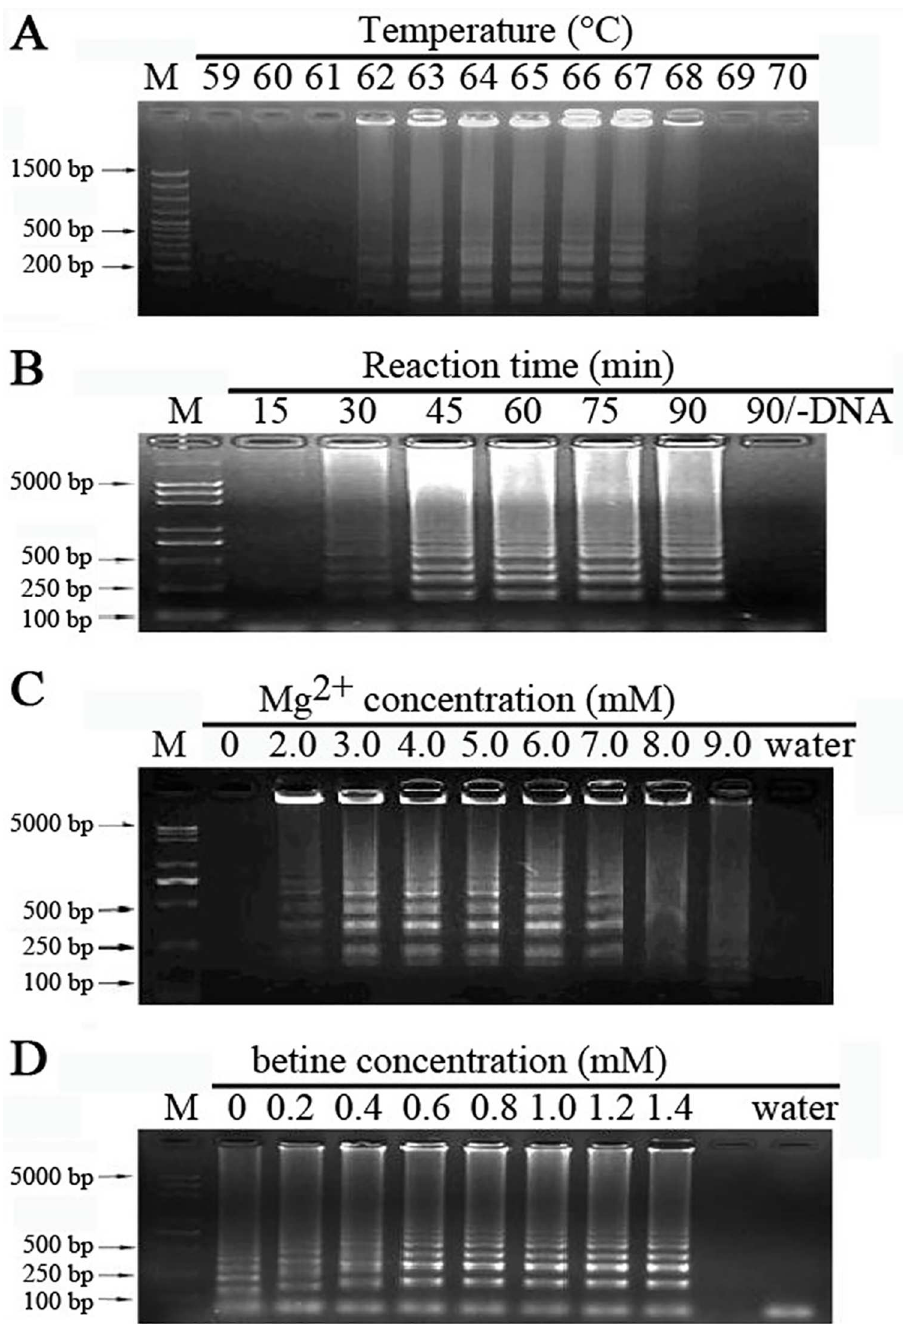
Fig 1. Optimization ofLAMP reactions. LAMP reactionwere carried out using genomicDNA from tachyzoites under variousconditions, as different reactiontemperatures (A), reactiontimes (B), Mg 2+ concentrations (C) and betine concentrations (D). Lane (M), DNA